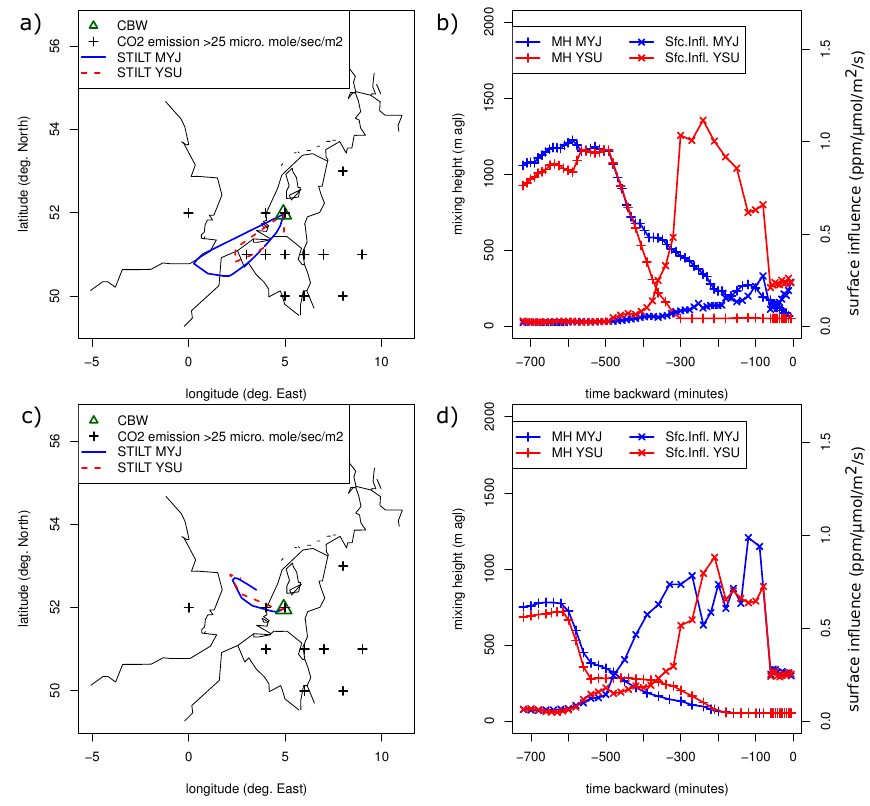
Figure 14. Comparison of STILT simulated surface influence using KED-optimized MHs. Shown are maps around the Cabauw tall tower (green triangle) in (a) and (c) together with polygons indicating the area covered by particles with non-zero surface influence in the last 12h before arrival at Cabauw for the STILT/MYJ (blue lines) and STILT/YSU (red dashed lines) simulations. These areas were approximated by convex hulls around horizontal particle distributions. Also shown are strong point sources in the EDGAR emissions (black pluses) on 7 September 2009, 00:00UTC (a, b) and 28 September 2009, 02:00UTC (c, d) when deviations in fossil fuel signals between the simulations were found most distinct (Fig. 9). Surface influence is also shown for the simulations STILT/MYJ (blue crosses) and STILT/YSU (red crosses) as a function of time before arrival at Cabauw (b, d) . The optimized MHs using WRF/MYJ (blue pluses) and WRF/YSU (red pluses) as external drift in KED are plotted for comparison. Although the same conditioning data were used, the estimated night-time MHs differ notably in (b) , leading to corresponding differences in surface